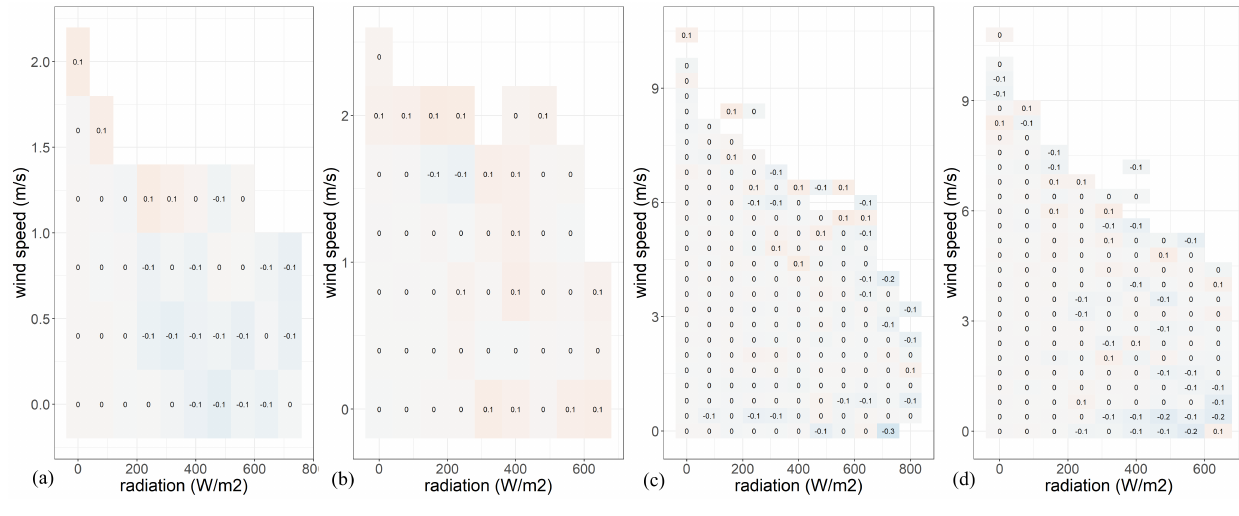
Figure 17. Same as Fig. 11 but for QC level 3. Table 11. Number and percentage of observations flagged as outliers during QC level 1 for 2019 Q3–Q4, 2020 Q1–Q4 and 2021 Q1–Q4 for all LC-X